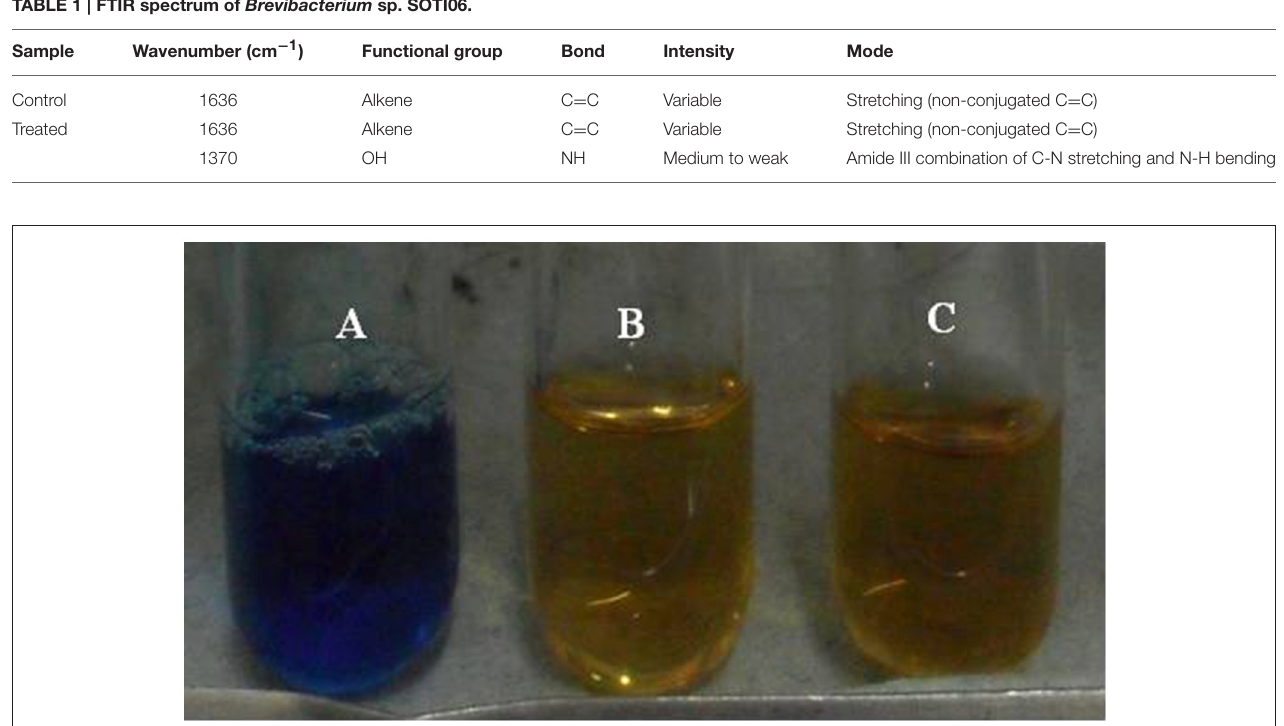
FIGURE 8 | Siderophore production by Brevibacterium sp. SOTI06. The siderophore production was estimated by CAS assay with reference (A) in the presence (B) and absence (C) of CaCO 3 . The change of color from blue to yellow indicated the siderophore